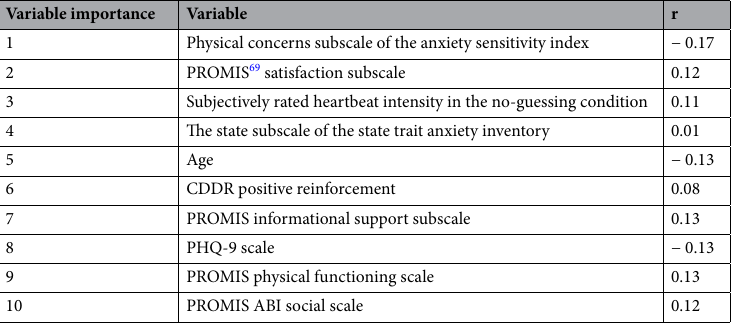
Table 3. Machine learning results. Top 10 variables of importance and associated univariate correlations in accounting for variance in interoceptive modulation